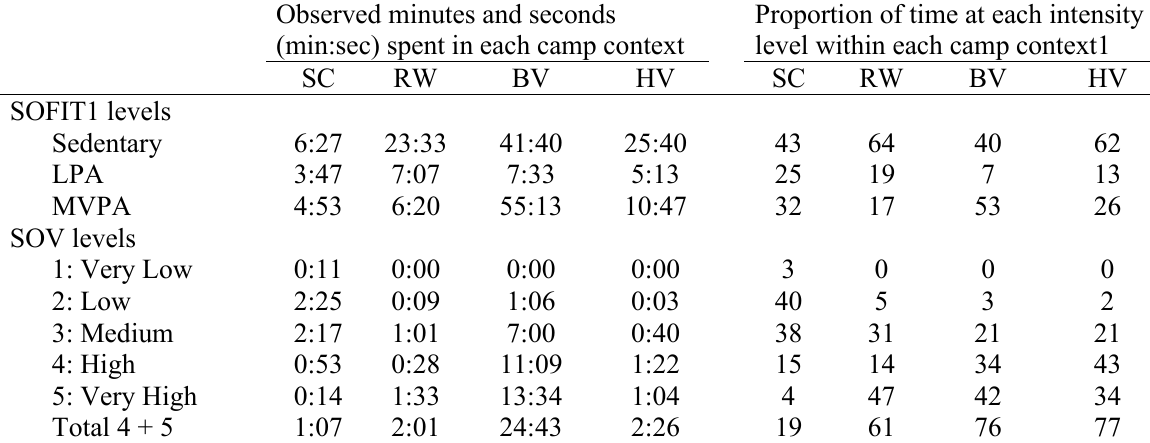
Table 3 . Average time (minutes and seconds) and SOFIT physical activity levels in four vaulting camp